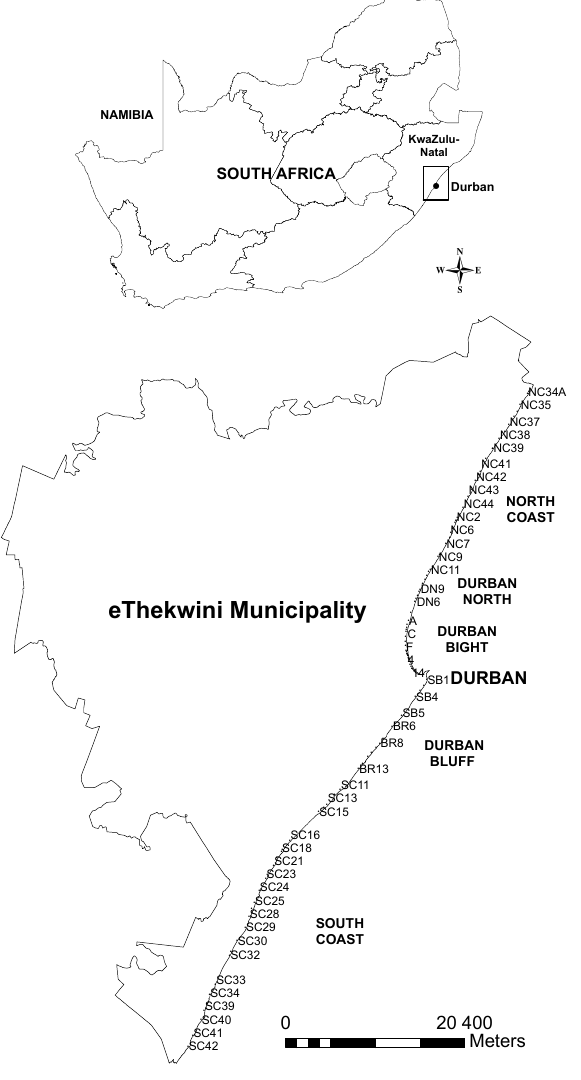
Fig. 1. A map of South Africa showing KwaZulu-Natal and Dur- ban and a map of the eThekwini Municipality showing the beach